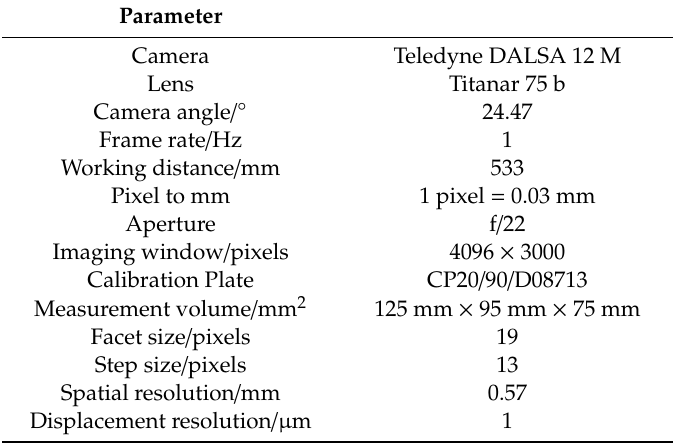
Table 2. Digital image correlation (DIC) instrumentation and setup